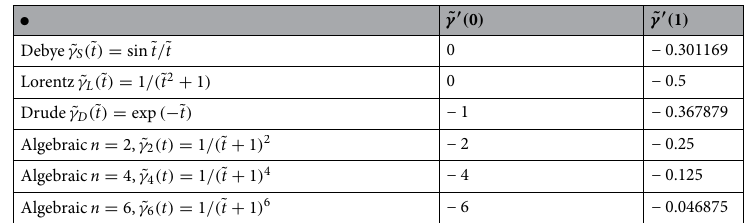
t ) of various dimensionless dissipation functions computed γ ′ ( ˜ ˜ τ c which characterizes the degree of non-Markovianity of the =